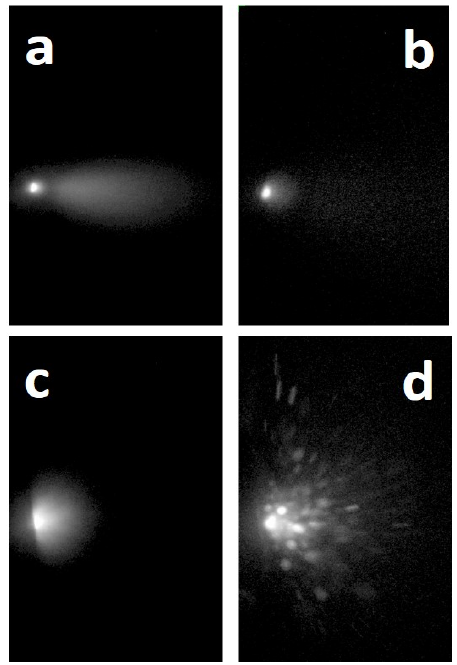
Figure 2. ICCD images of the plume obtained using fs ablation of a C 60 target: ( a ) delay 50 ns, gate 200 ns; ( b ) delay 250 ns, gate 200 ns; ( c ) delay 2 µ s, gate 2 µ s; ( d ) delay 15 µ s, gate 2 µ s. The dimensions of the rectangular areas are 1 × 1.6 cm. Reprinted with permission from [31]. Copyright 2013 Elsevier.